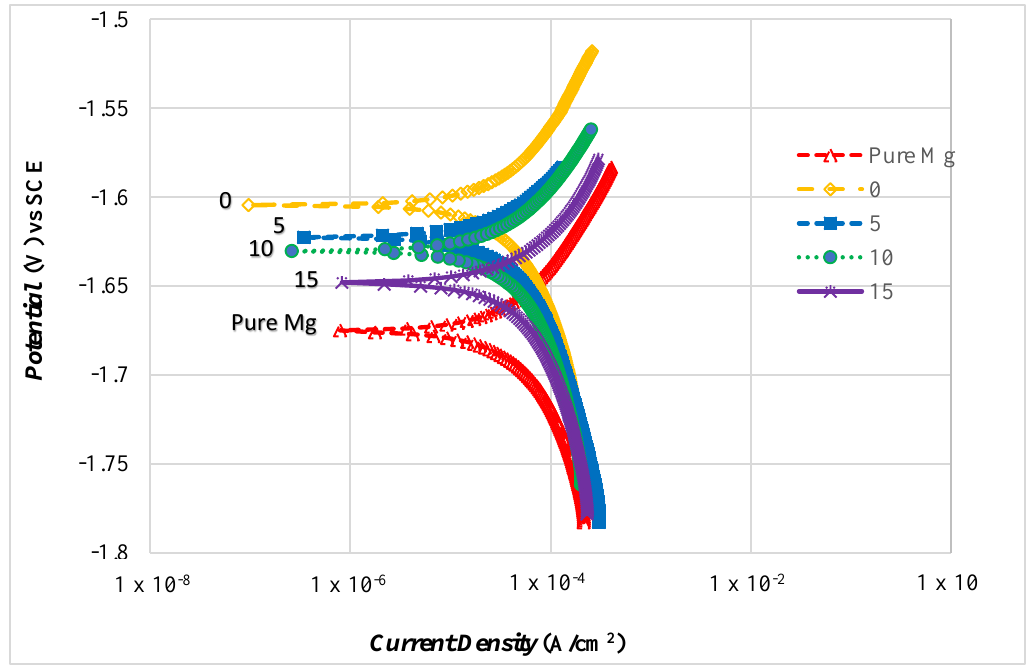
Figure 11 . Polarization test for the Mg-Zn/HAP/Al 2 O 3 composite. Figure 11. Polarization test for the Mg-Zn/HAP/Al 2 O 3